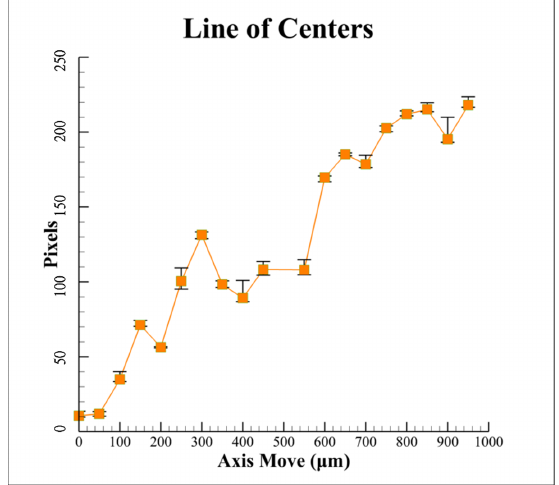
Figure 8. Measurement results of proposed algorithm for variation of distance L between centroid and geometric center with defocus distance.